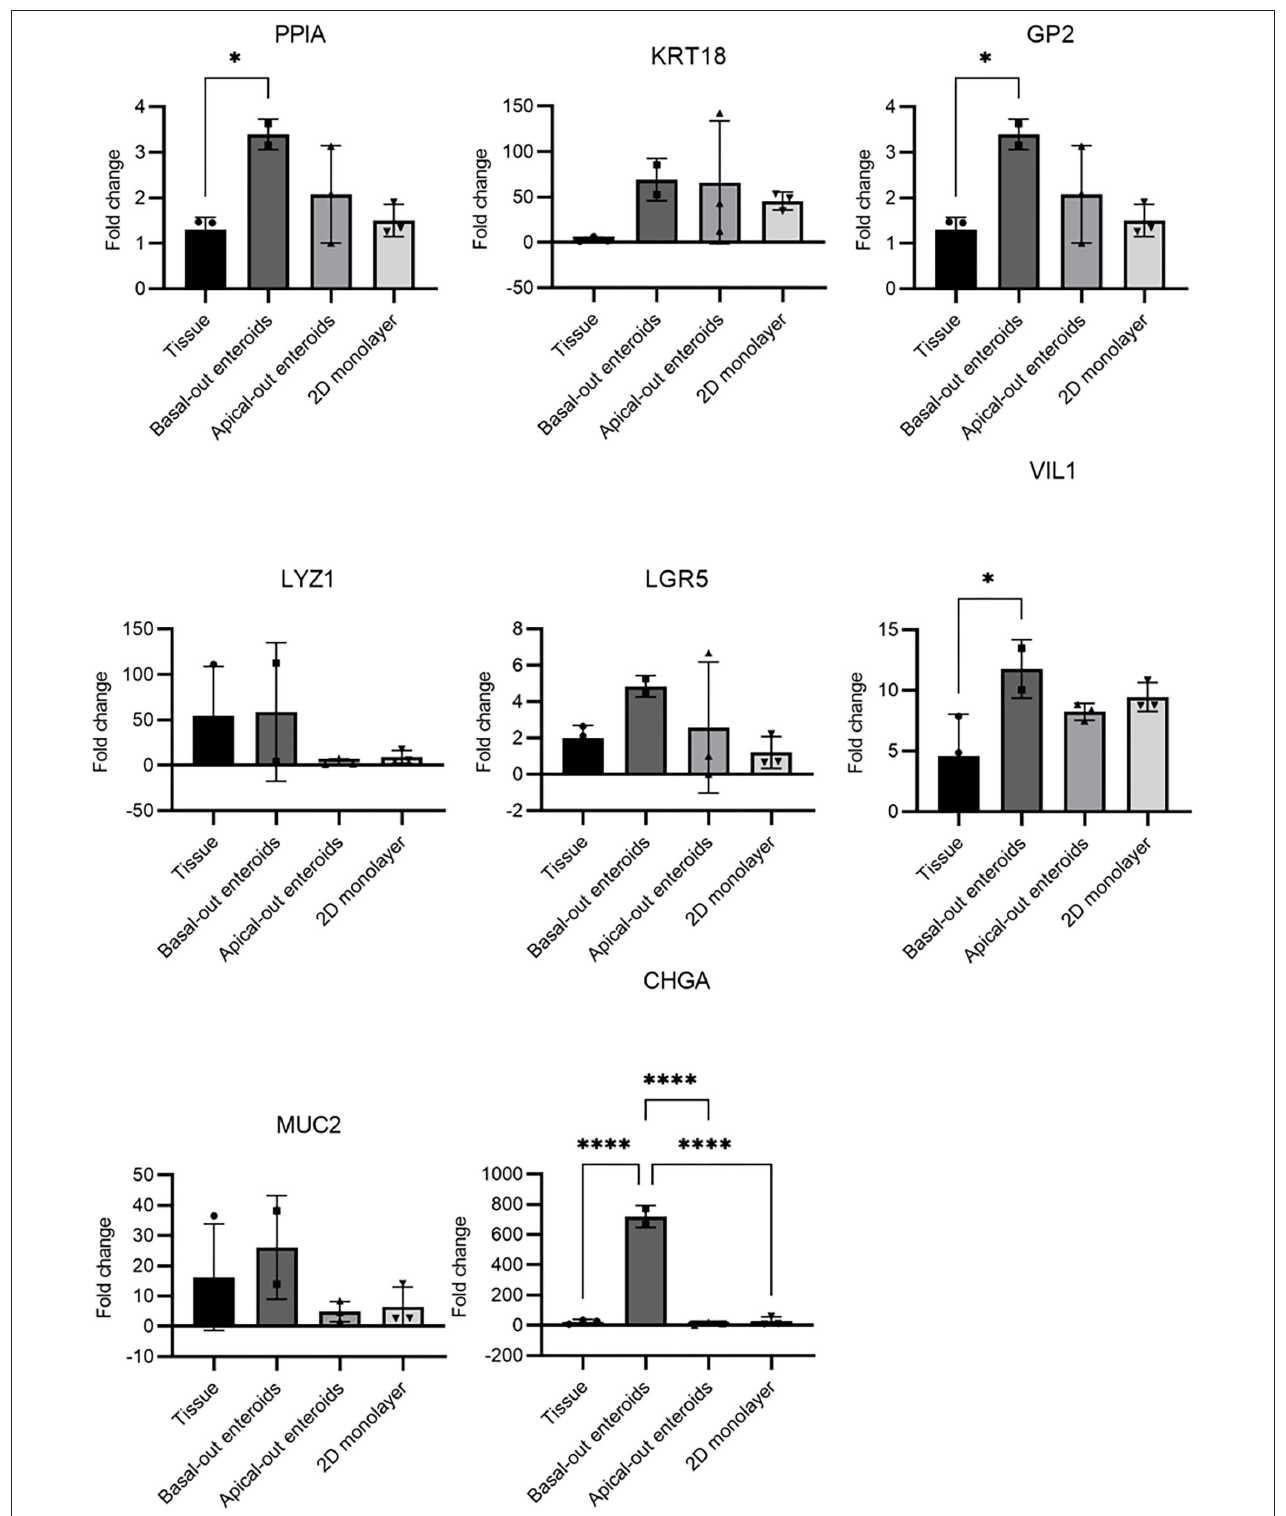
FIGURE 4 | RT-qPCR of mRNA expression indicative of specific cell types in enteroid-derived models. The gene expression was determined by RT-qPCR and calculated as fold change relative to the expression of ACTB and REPS1 as endogenous reference genes. Total RNA was isolated from the samples and confirmed to be free of genomic DNA. The results are from samples derived from 2 independent animals, with 3 technical repeats and presented as mean values ± standard deviation (SD). Statistical analysis was performed with a one-way ANOVA; * = P ≤ 0.05; ** = P ≤ 0.01; *** = P ≤ 0.001; **** = P ≤ 0.0001.